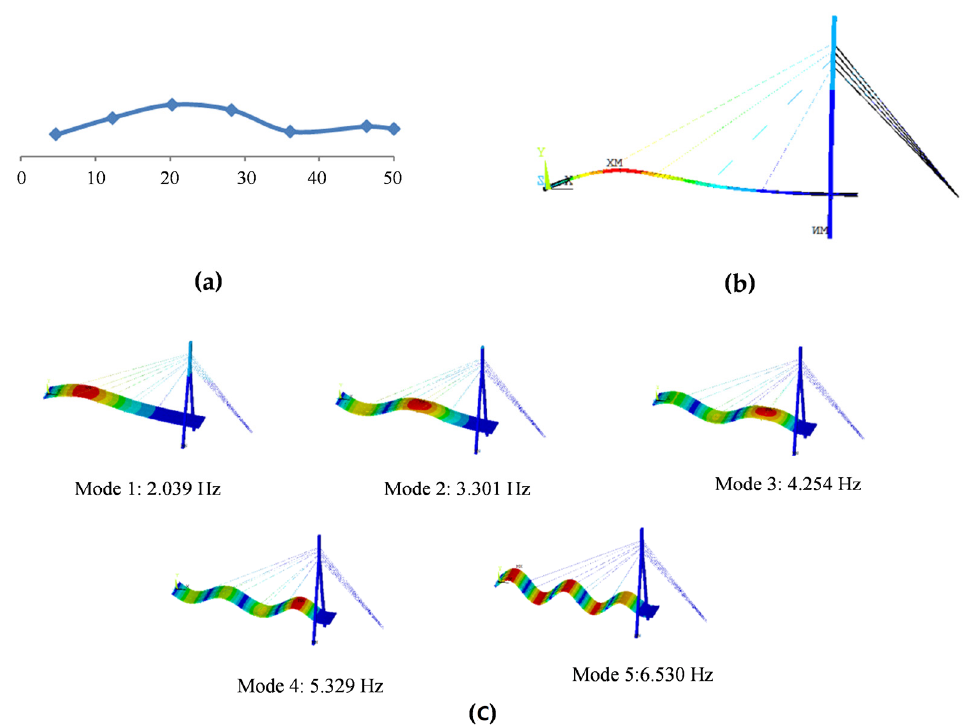
Figure 8. The first five mode shapes of the cable-stayed bridge [18]. ( a ) The 1st test mode shape [32];